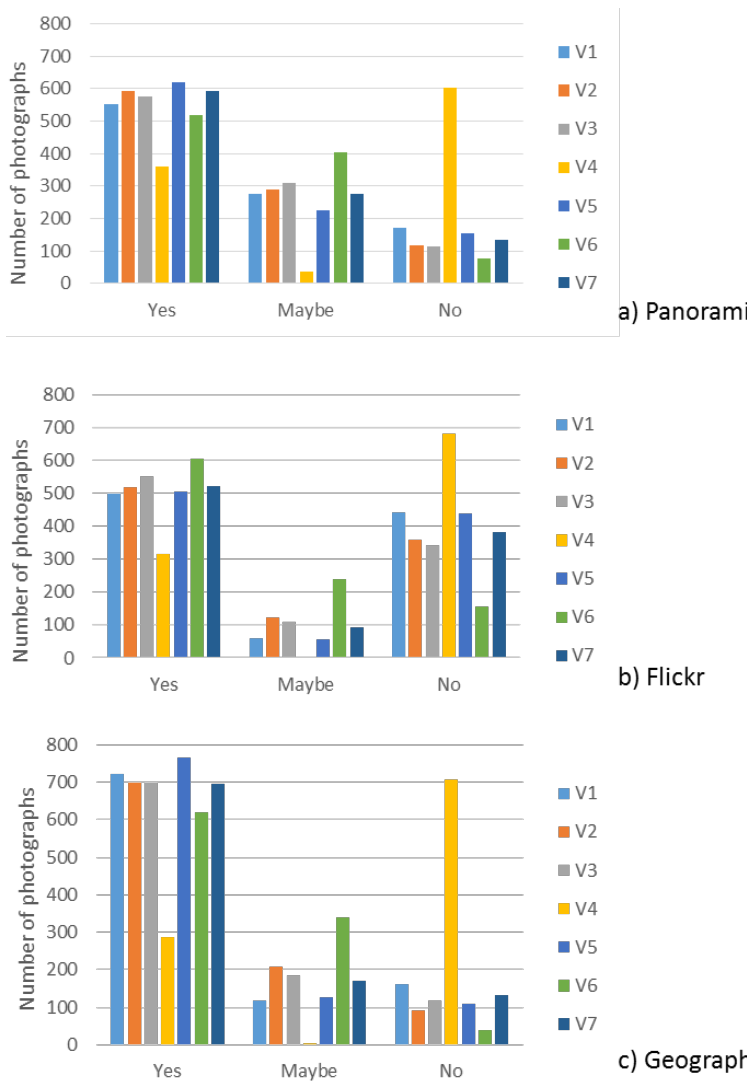
Figure 3. Number of photographs assigned to each class “Yes”, “Maybe” or “No” by the seven volunteers Vi ( i = 1, …, 7) for ( a ) Panoramio; ( b ) Flickr and ( c ) Geograph.